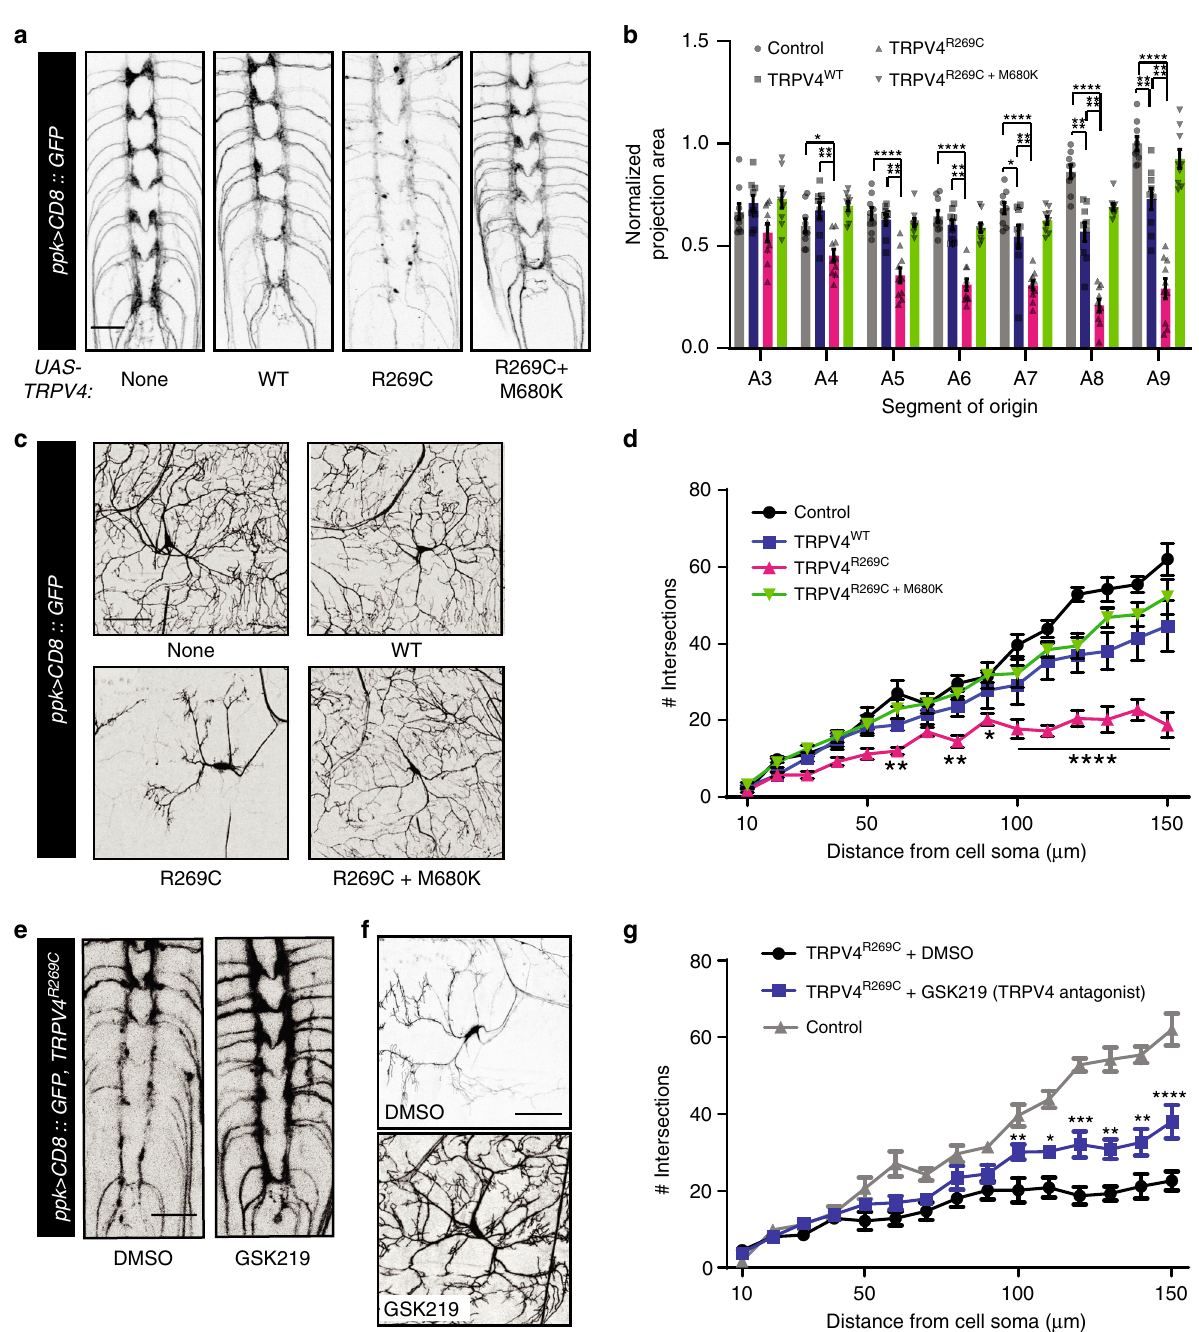
Fig. 2 High TRPV4 R269C expression disrupts C4da neuron axonal and dendritic projections. Confocal projections of C4da neuron axonal projections a and dendrites c from wandering third instar larvae expressing TRPV4 (high) variants. b Mean ± SEM normalized projection areas in a . n = 9 (control), 9 (TRPV4 WT ), 10 (TRPV4 R269C ), and 9 (TRPV4 R269C + M680K ) larvae. Two-way ANOVA ( p <0.0001), Tukey ’ s post hoc test. d Sholl analysis of neurons in c . Mean ± SEM. n = 5 cells, one per larva, from fi ve larvae per genotype. Asterisks denote difference from no TRPV4 (control). Two-way ANOVA ( p <0.0001), Tukey ’ s post hoc test. Confocal stacks of axonal projections e and dendrites f of fl ies expressing TRPV4 R269C (high) raised on food with either DMSO or 100 μ M GSK219. g Sholl analysis of dendritic phenotypes in f . Control from d shown for reference. Mean ± SEM. n = 6 cells from three larvae for DMSO, n = 10 cells from fi ve larvae for GSK219. Asterisks denote differences from DMSO. Two-way ANOVA ( p <0.0001), Tukey ’ s post hoc test. Scale bar, 25 µ m in a and e and 50 µ m in c and f . For all panels: * p <0.05, ** p <0.01, *** p <0.001, and **** p